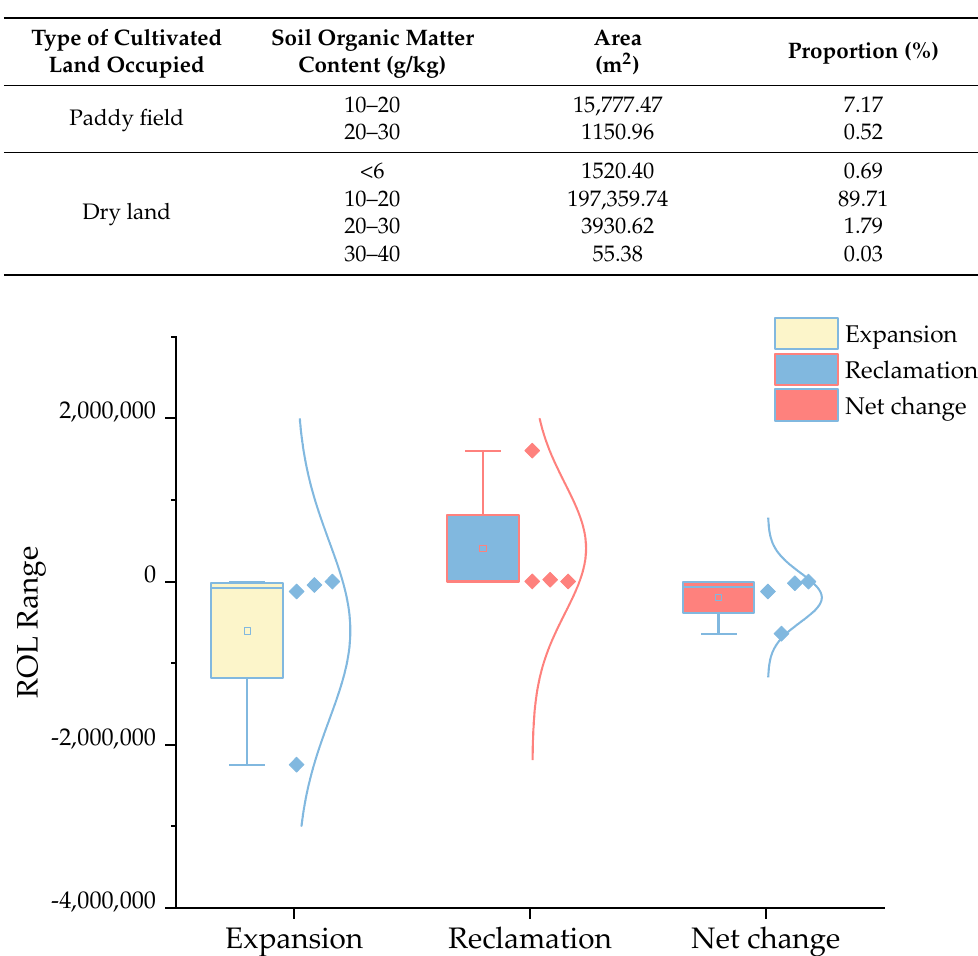
Figure 6. Statistics of the index of cultivated land occupied by rural settlements.